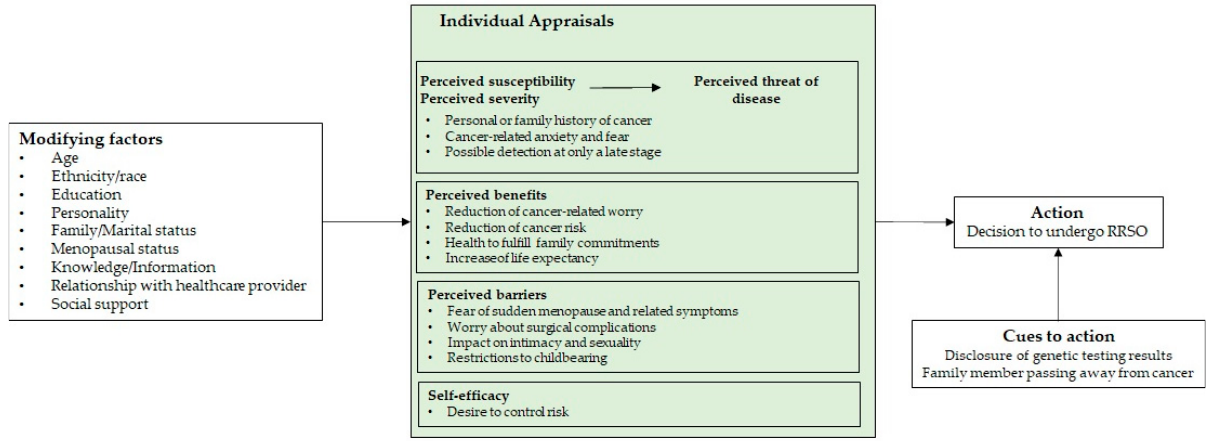
Figure 1. The adapted application of the HBM to women’s decision to undergo RRSO. Key concepts: Perceived susceptibility—belief about the likelihood of getting a disease or condition; Perceived severity—belief about the seriousness of contracting an illness or of leaving it untreated; Perceived threat of disease—combination of perceived susceptibility and severity; Perceived benefits—belief in efficacy of advised action to reduce risk; Perceived barriers—belief about the tangible and psychological costs of the advised action; Self-efficacy—confidence in one’s ability to take action. How to read the model: when confronted with contextual cues that demand a decision as to whether to undergo RRSO, women are more likely to decide favorably if they regard themselves as susceptible to cancer, believe that getting cancer would have potentially serious consequences, believe that the benefits of undergoing RRSO outweigh its costs (barriers), and believe they are capable of making that decision. All these appraisals may also be influenced by women’s sociodemographic, psychological, structural, and relational factors (adapted from [49,50]).